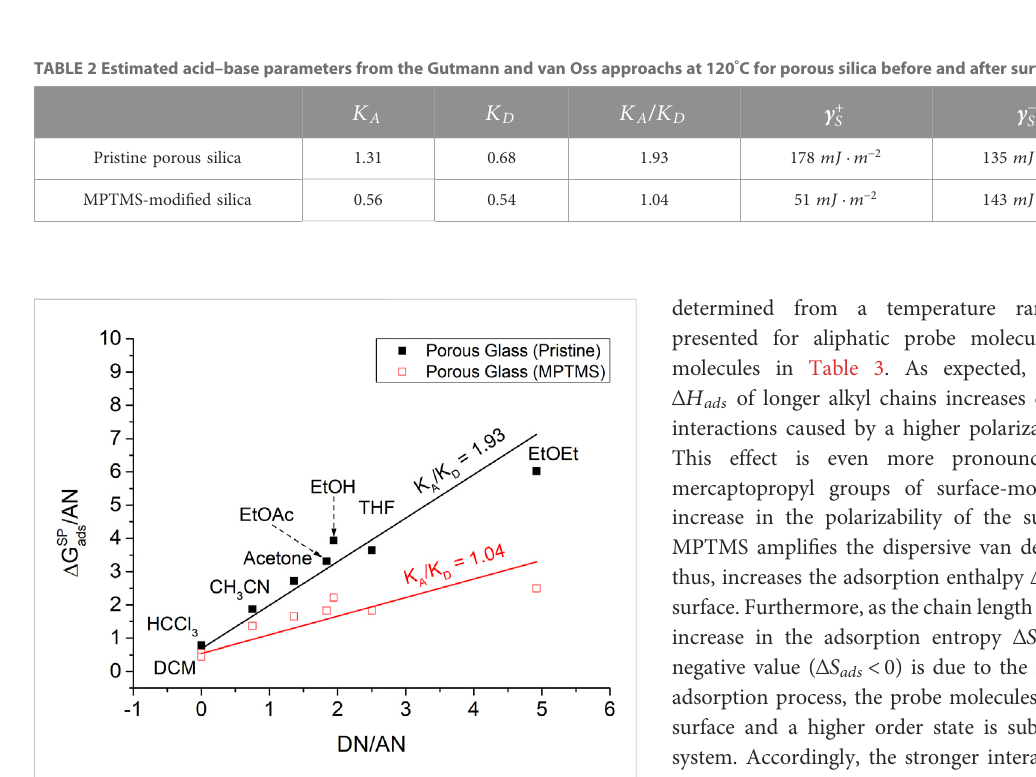
FIGURE 6 Determinationoftheacidandbaseparameters( K A ; K D )usingthe Gutmann approach at 120 ° C for macro-porous silica before ( ■ ) and after ( □ ) surface modi fi cation with